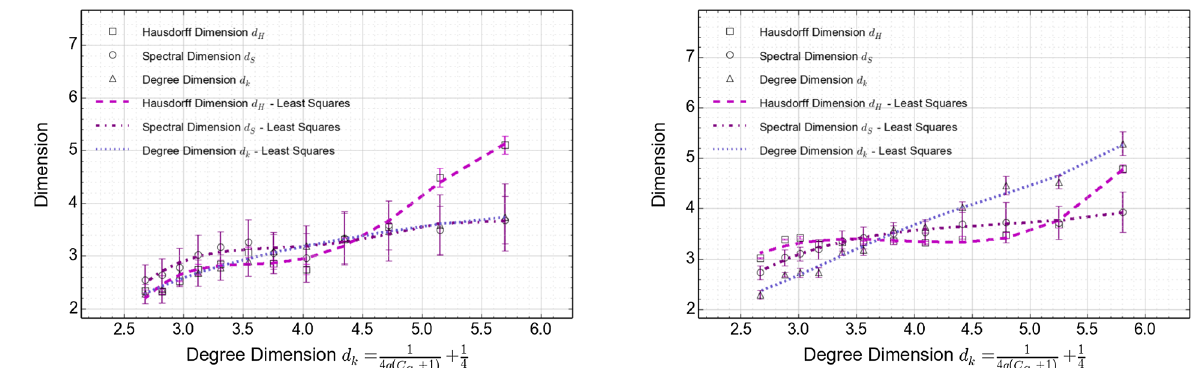
with λ 4 = 0 . 0 across a range of d k , computed using